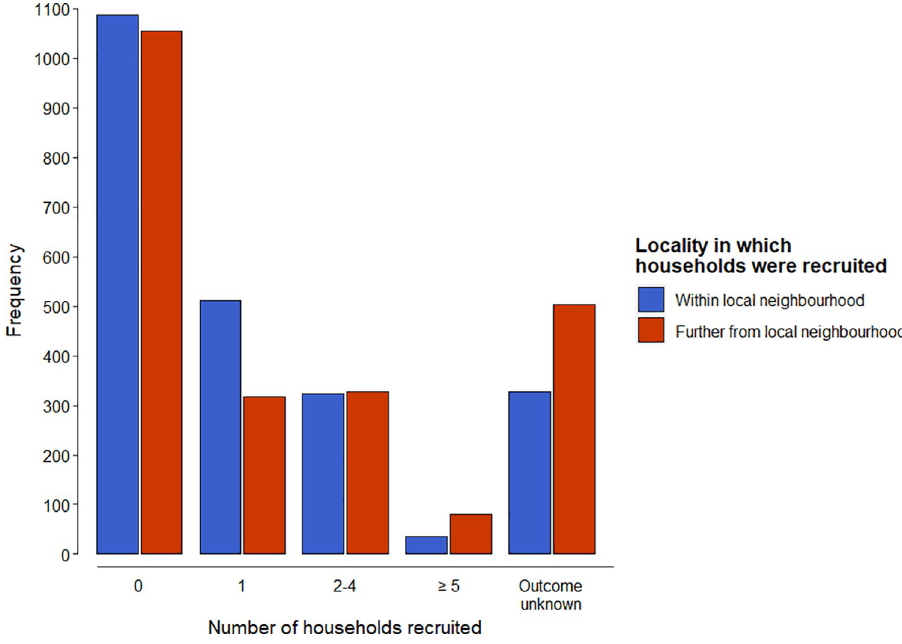
Fig 3. The number of additional households recruited to make hedgehog highways by Champions who had already made highways themselves (N = 2285) within their own neighbourhood and / or further